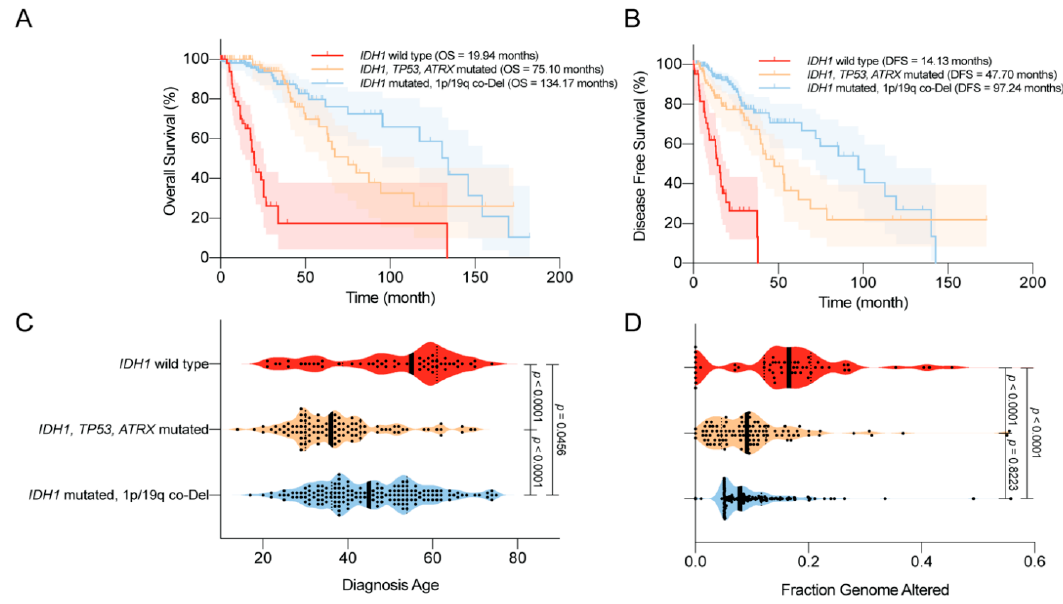
Figure 3. Clinical features of the World Health Organization (WHO) grade II / III IDH -mutated glioma. ( A ) Overall survival (OS) of glioma patients according to IDH1 status. IDH1 mutations are associated with prolonged OS. ( B ) Disease-free survival (DFS) of glioma patients according to IDH1 status. IDH1 mutations are associated with prolonged DFS. ( C ) Age at diagnosis among glioma patients according to IDH1 status. IDH1 mutations are associated with a younger age at diagnosis. ( D ) The distribution of genome alterations in glioma according to IDH1 status. IDH1 mutations are associated with fewer